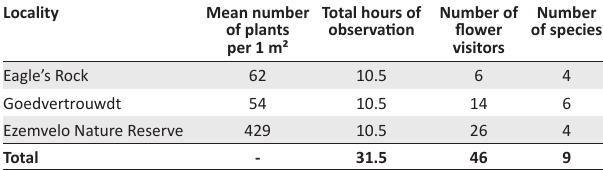
TABLE 1: Overview of time spent and flower visitors recorded during the survey.